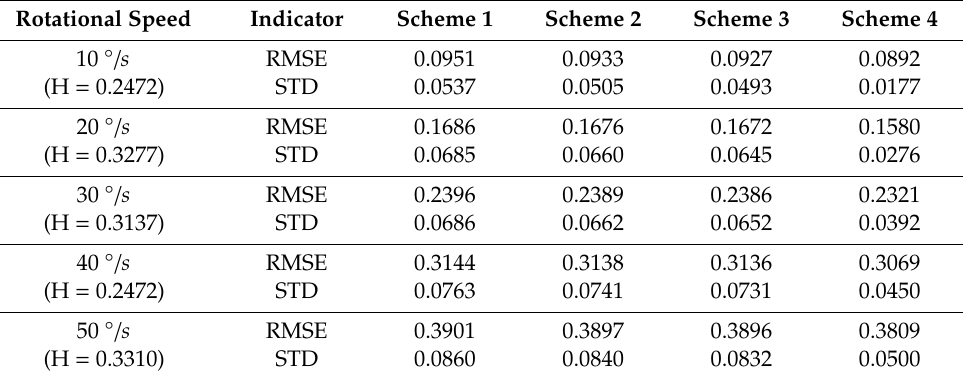
Table 2. Comparison of root mean square error (RMSE) and standard deviation (STD) for the denoising results of dynamic signals with di ff erent rotational